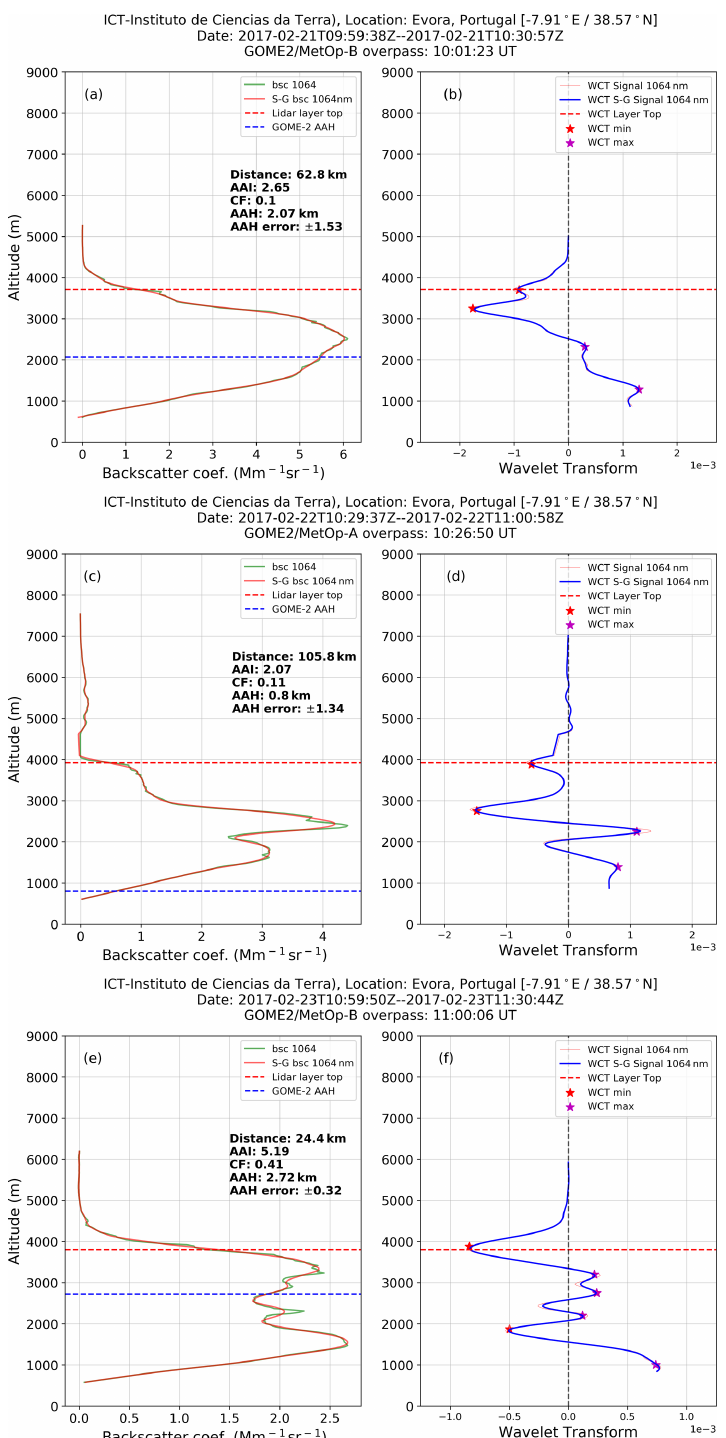
Figure 14. Évora lidar backscatter profiles (red and green lines; a , c and e ) and WCT method applied at 1064nm (stars; b , d and f ) and GOME-2A, GOME-2B AAH (dashed blue line) and associated error, AAI, CF and distance (legend) for 21 (a–b) , 22 (b–c) and 23 Febru- ary (e–f)